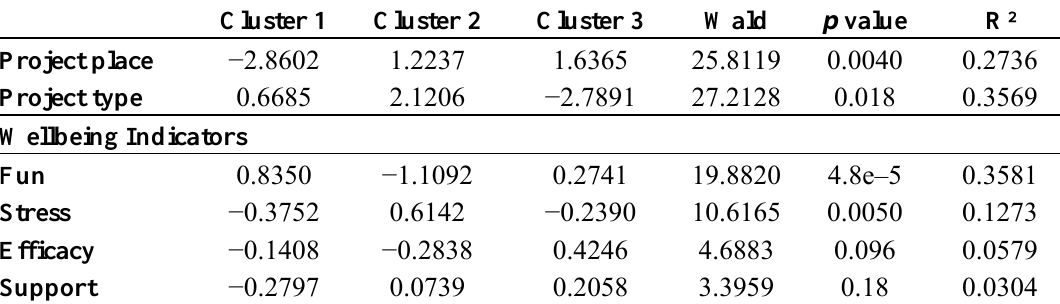
Table 4. Parameters discriminating between clusters.